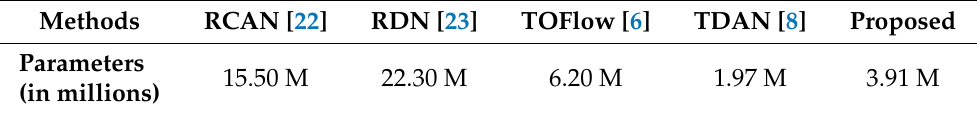
Table 4. Numbers of parameter in millions of different networks with leading VSR